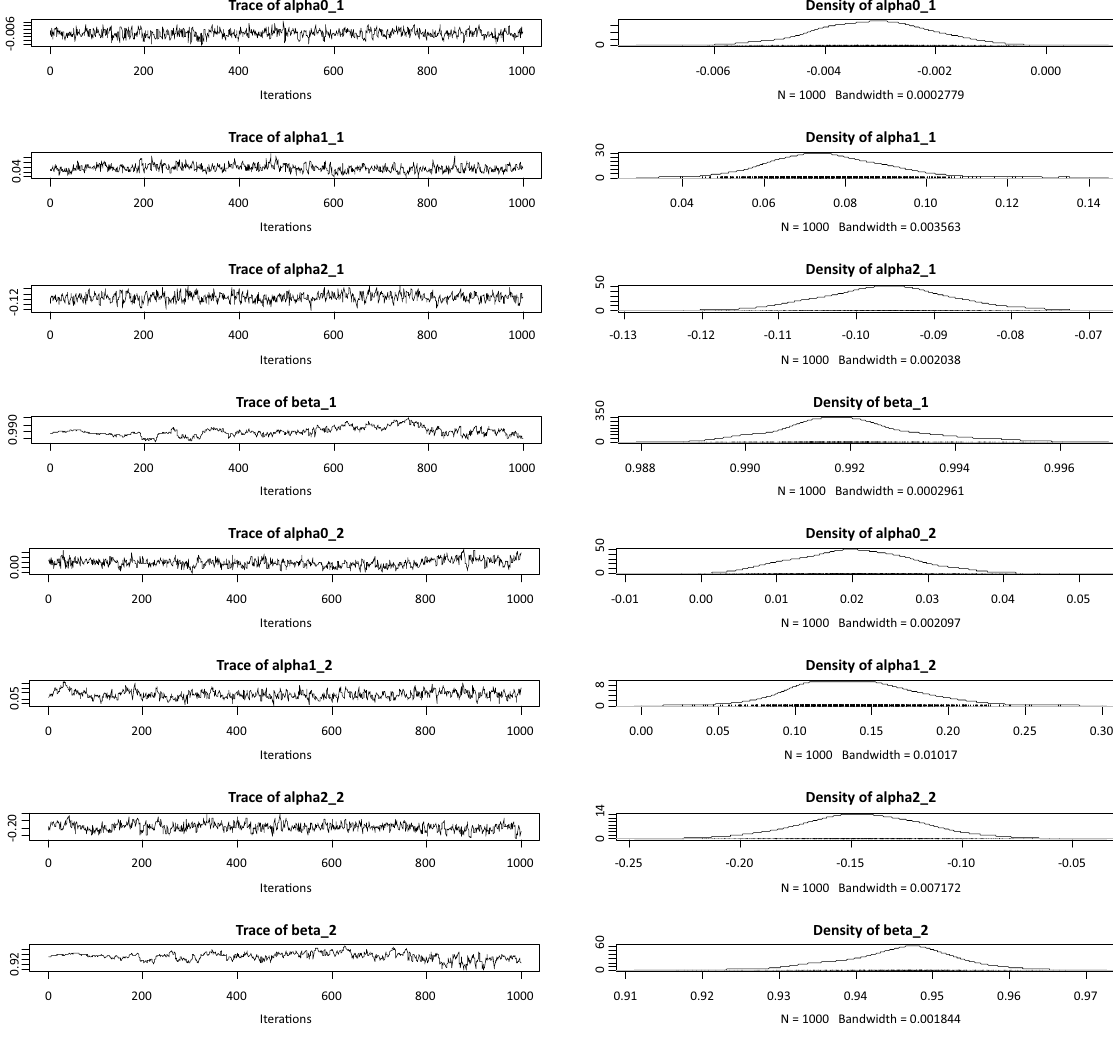
Figure 4. Trace of MCMC samples for the parameters of the two-regime EGARCH